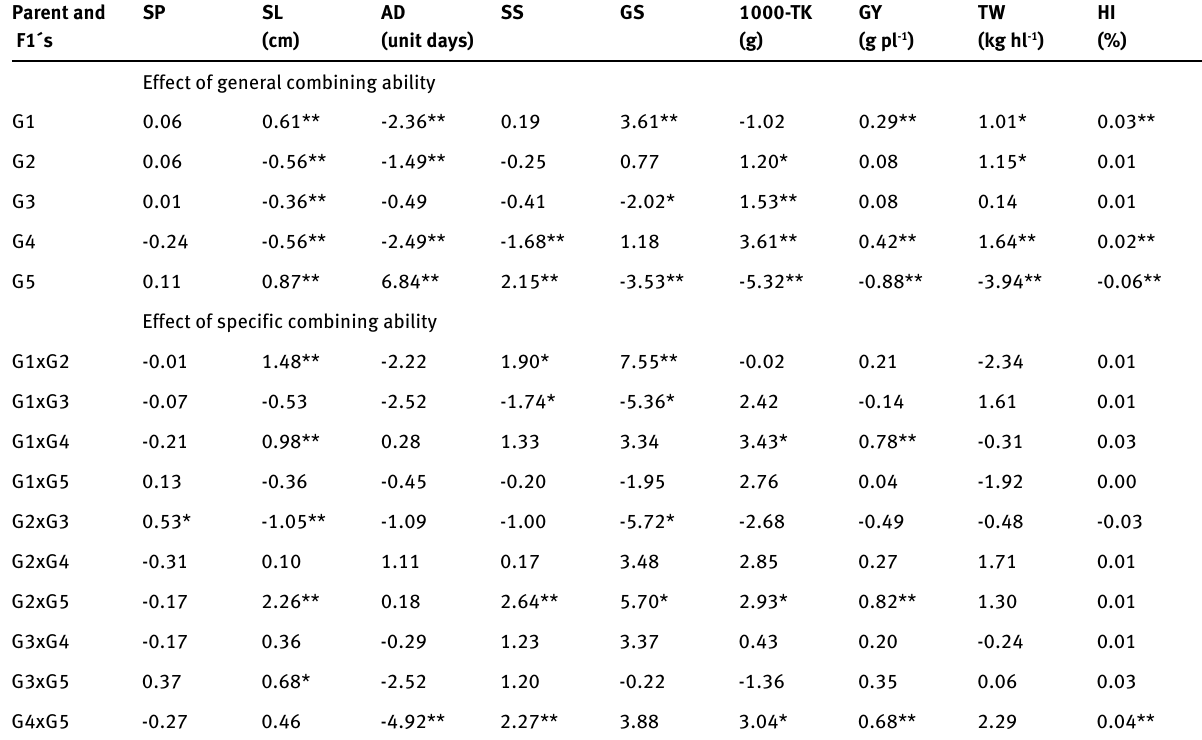
Table 3: Effects of general and specific combining ability for different traits in Triticale genotypes Parent and